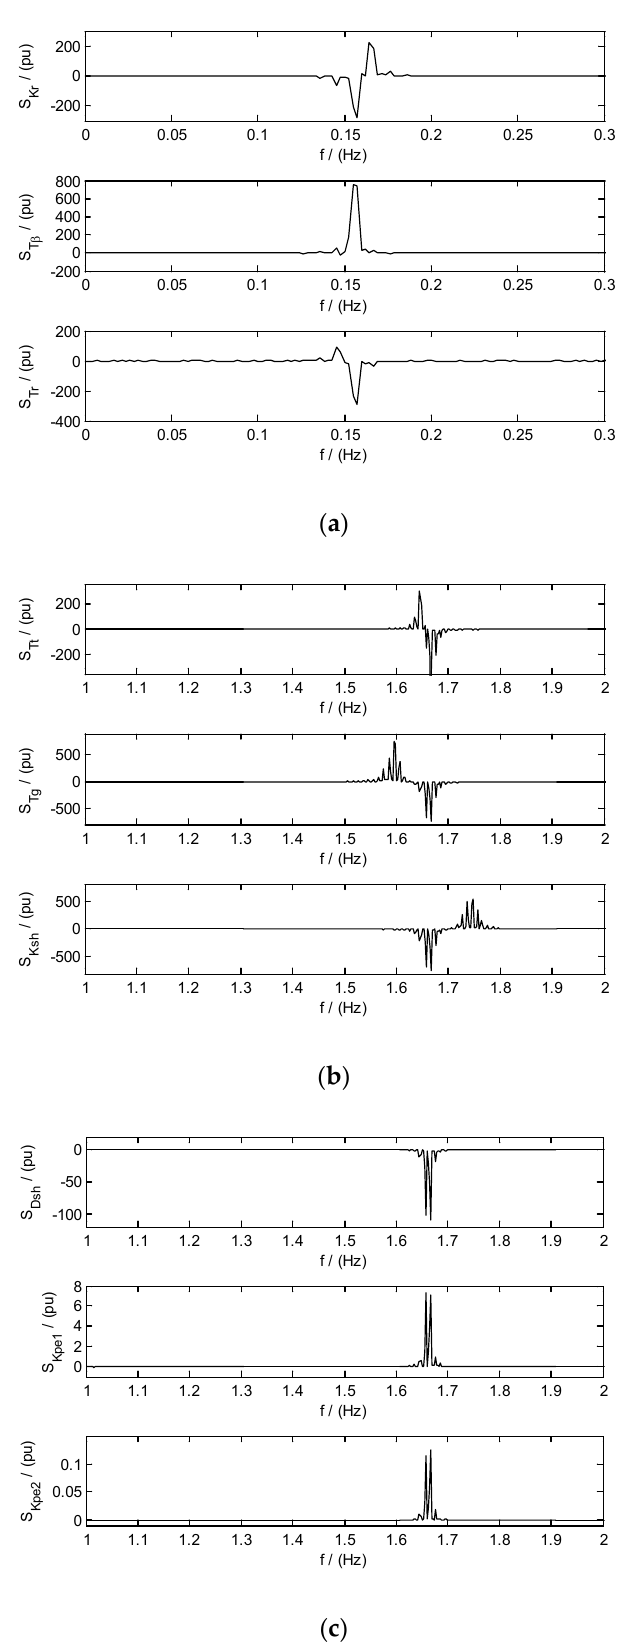
Figure 5. PSD sensitivity curves of each parameter. ( a ) θ 1 ; ( b ) T t , T g and K sh ; ( c ) D sh , K pe 1 and K pe 2 .